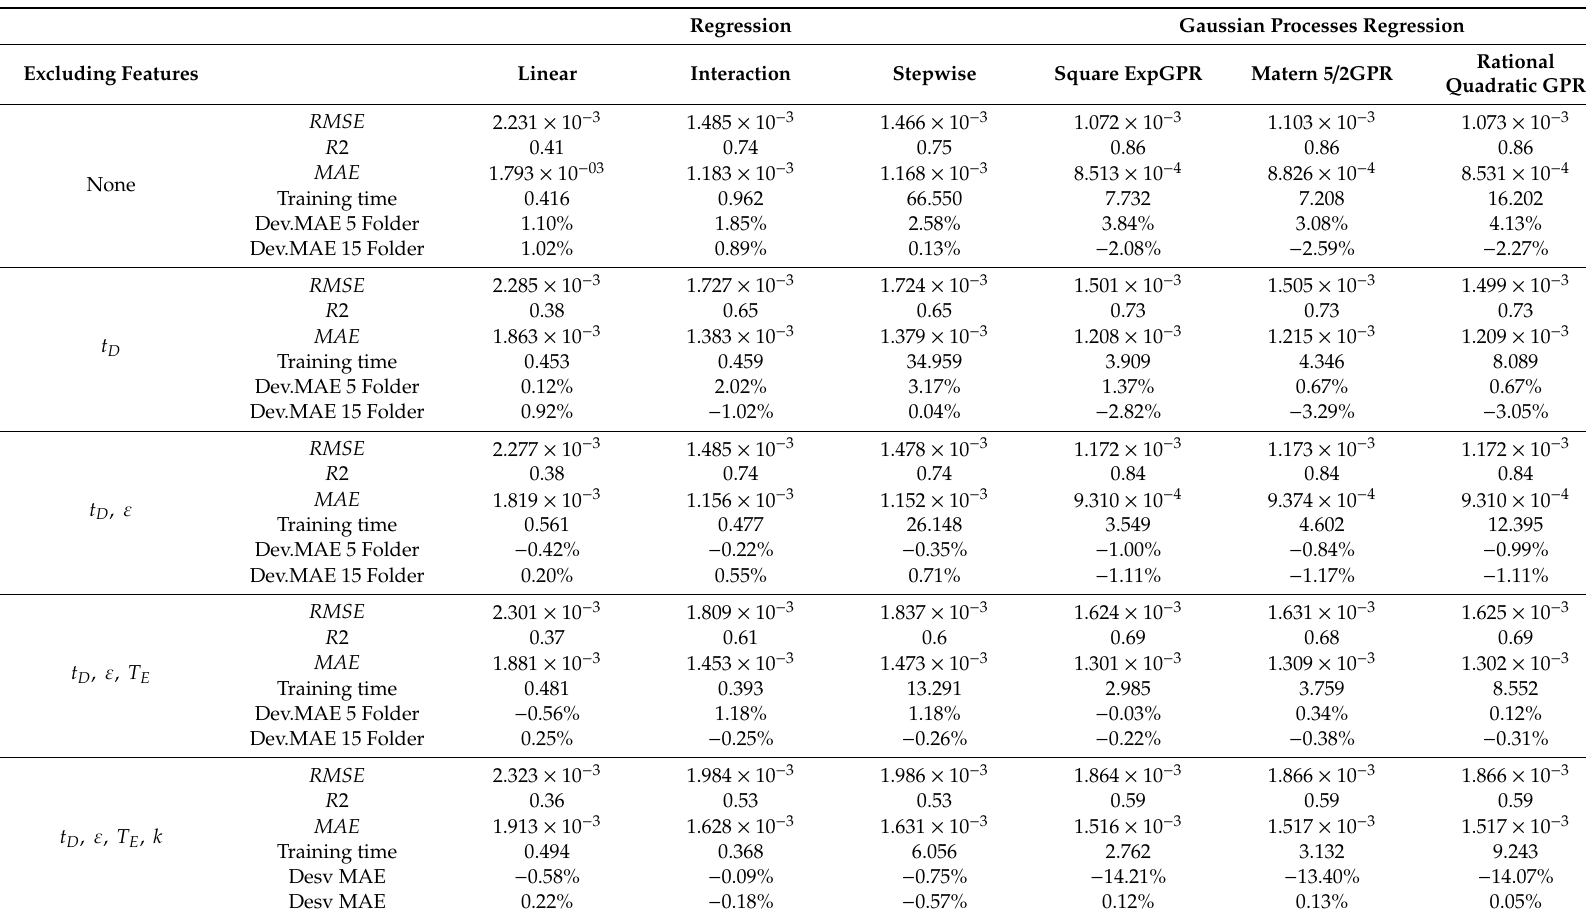
Table A5. Performance results for defect length predictor models using dataset of 500 sets of values. Regression and GPR when “Contrast Rear” is not contemplated as